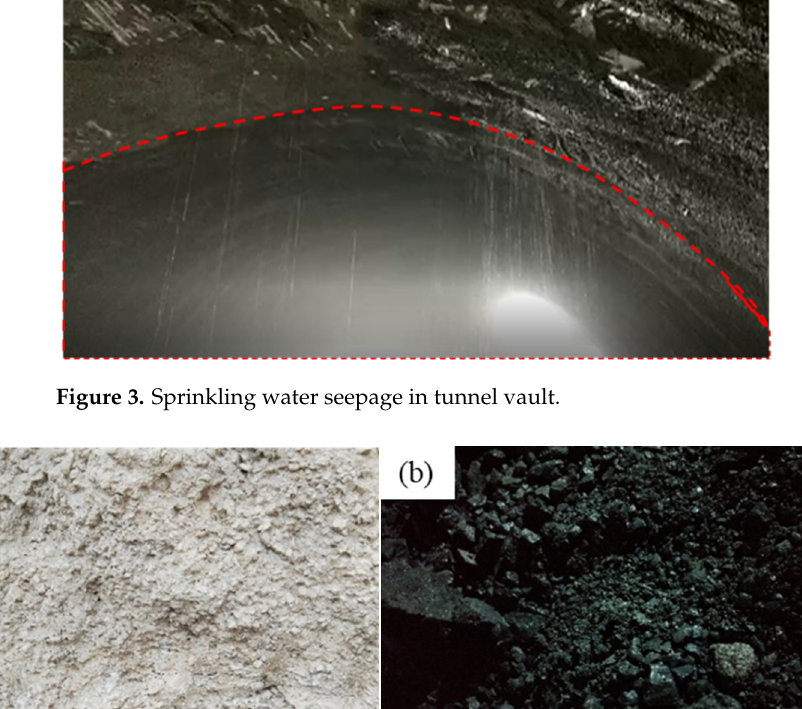
Figure 5. Unloading stress-strain curves of typical rock under water–rock interaction. According to the results of laboratory tests such as water-saturation test, wet-dry cy- cle test, and field observation, the strength, elastic modulus, cohesion, and internal friction angle of saturated limestone specimens are reduced, and the degree of reduction is related to many parameters such as initial confining pressure, water immersion time of rock sam- ples, osmotic pressure, and internal fractures. In the saturated state, the increase of the confining pressure makes the internal microcracks close, which leads to the strengthening of the deformation resistance of the rock, so the larger parameters such as compressive